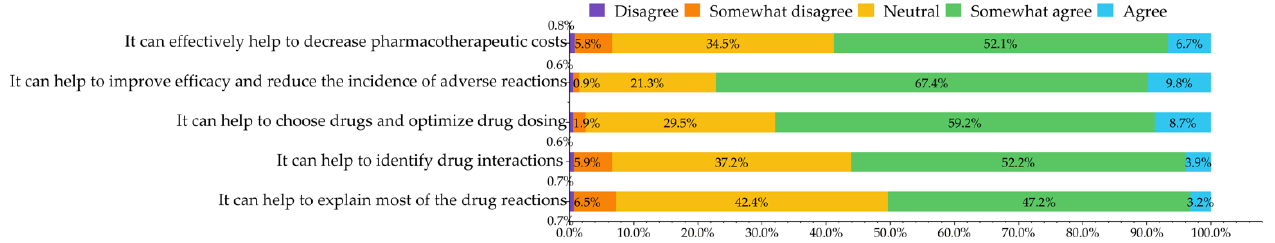
Figure 3. Attitudes towards the role and clinical effect of pharmacogenomic testing .